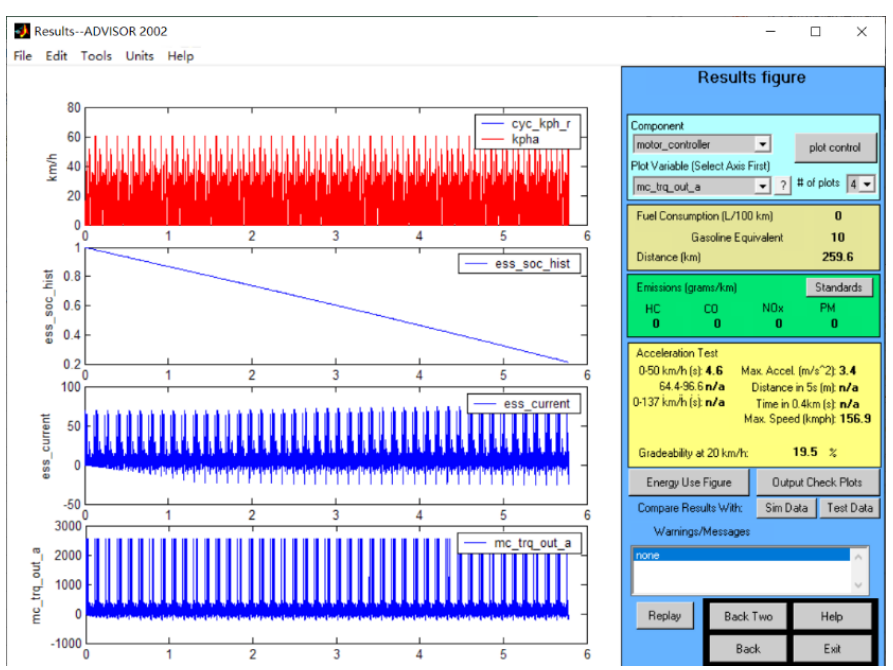
Figure 10. Simulation results of experiment 2.